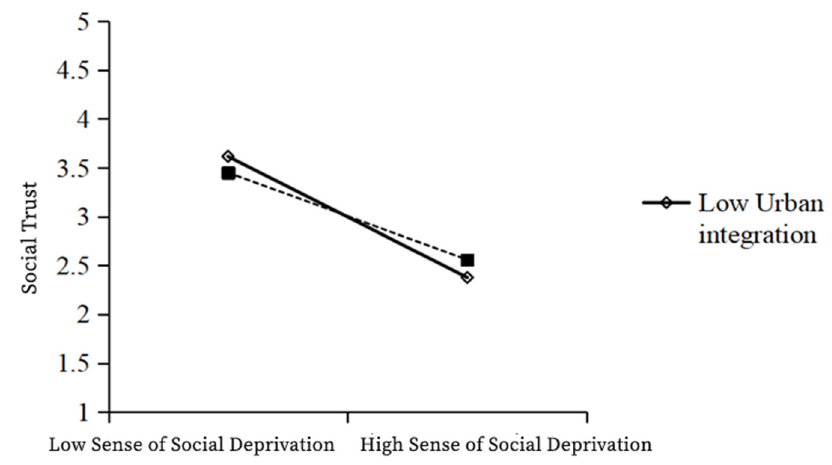
Table 11. Test of the moderating effect of urban integration between perception of social deprivation and social trust.